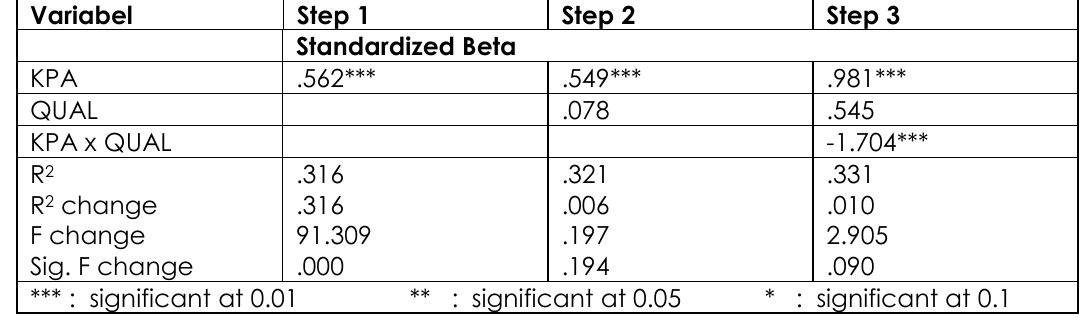
Table 11: Pengaruh Moderasi Quality